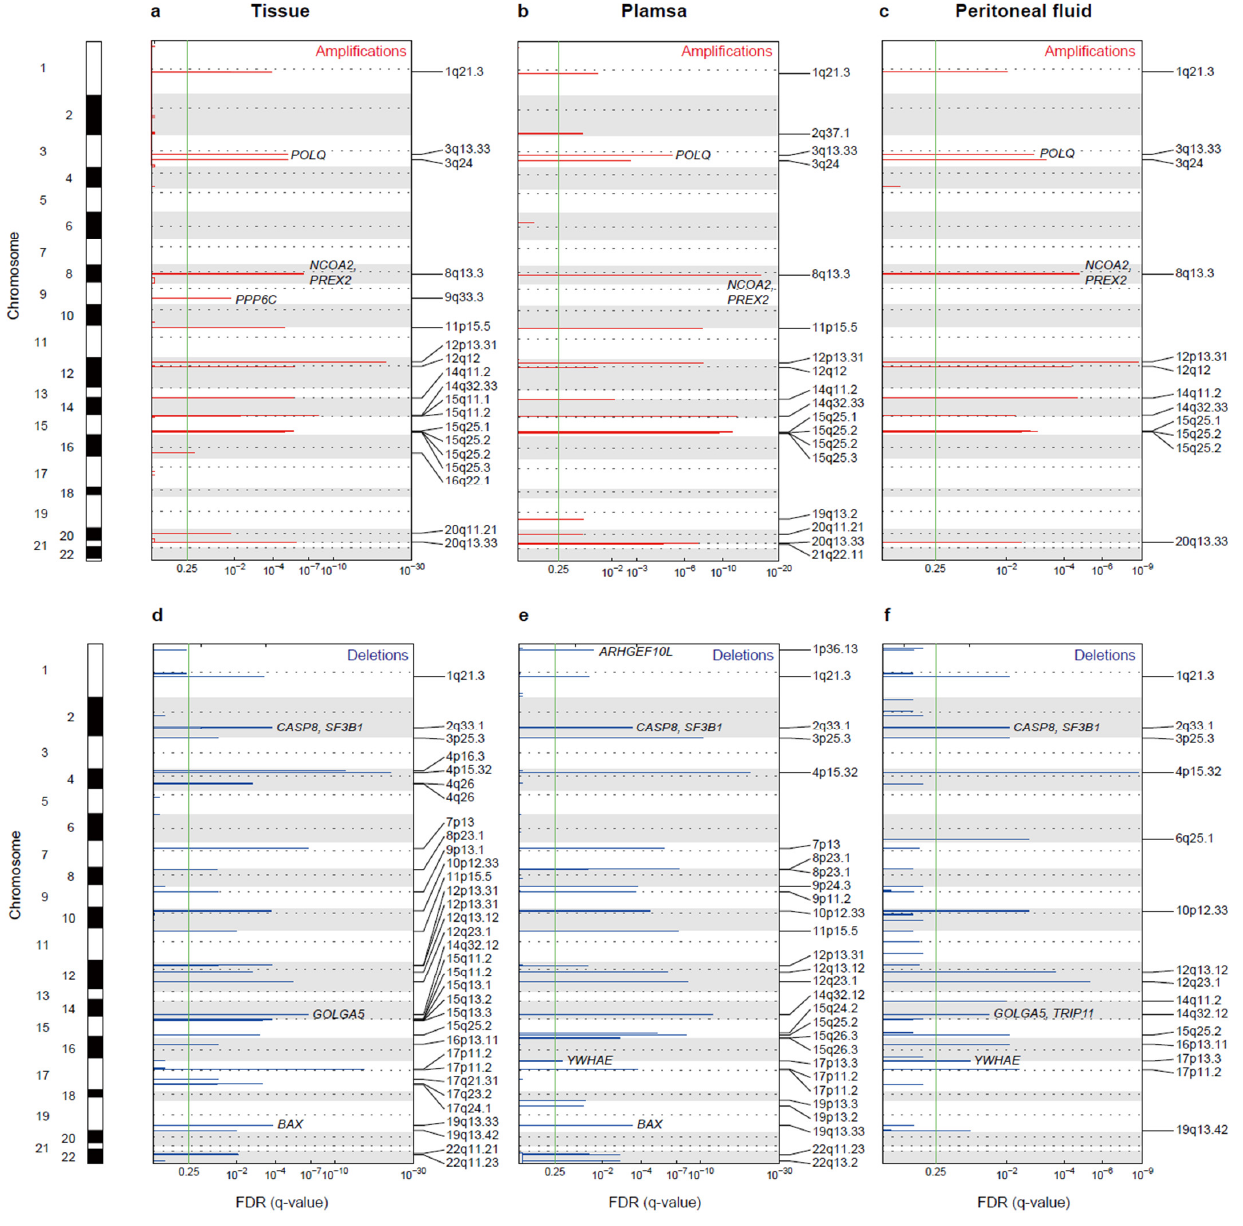
Figure 4. Recurrent CNAs in EC. ( a–c ) GISTIC2.0 analysis showing recurrent focal amplified regions and ( d – f ) deleted regions in the tissue, plasma, and peritoneal fluid samples of EC patients. The x -axis represents the FDR q -value, and the y -axis represents the chromosome. Cancer-related genes are labeled in each peak. Red and blue lines indicate amplification and deletion peaks, respectively. The green line indicates a q -value threshold of 0.25.